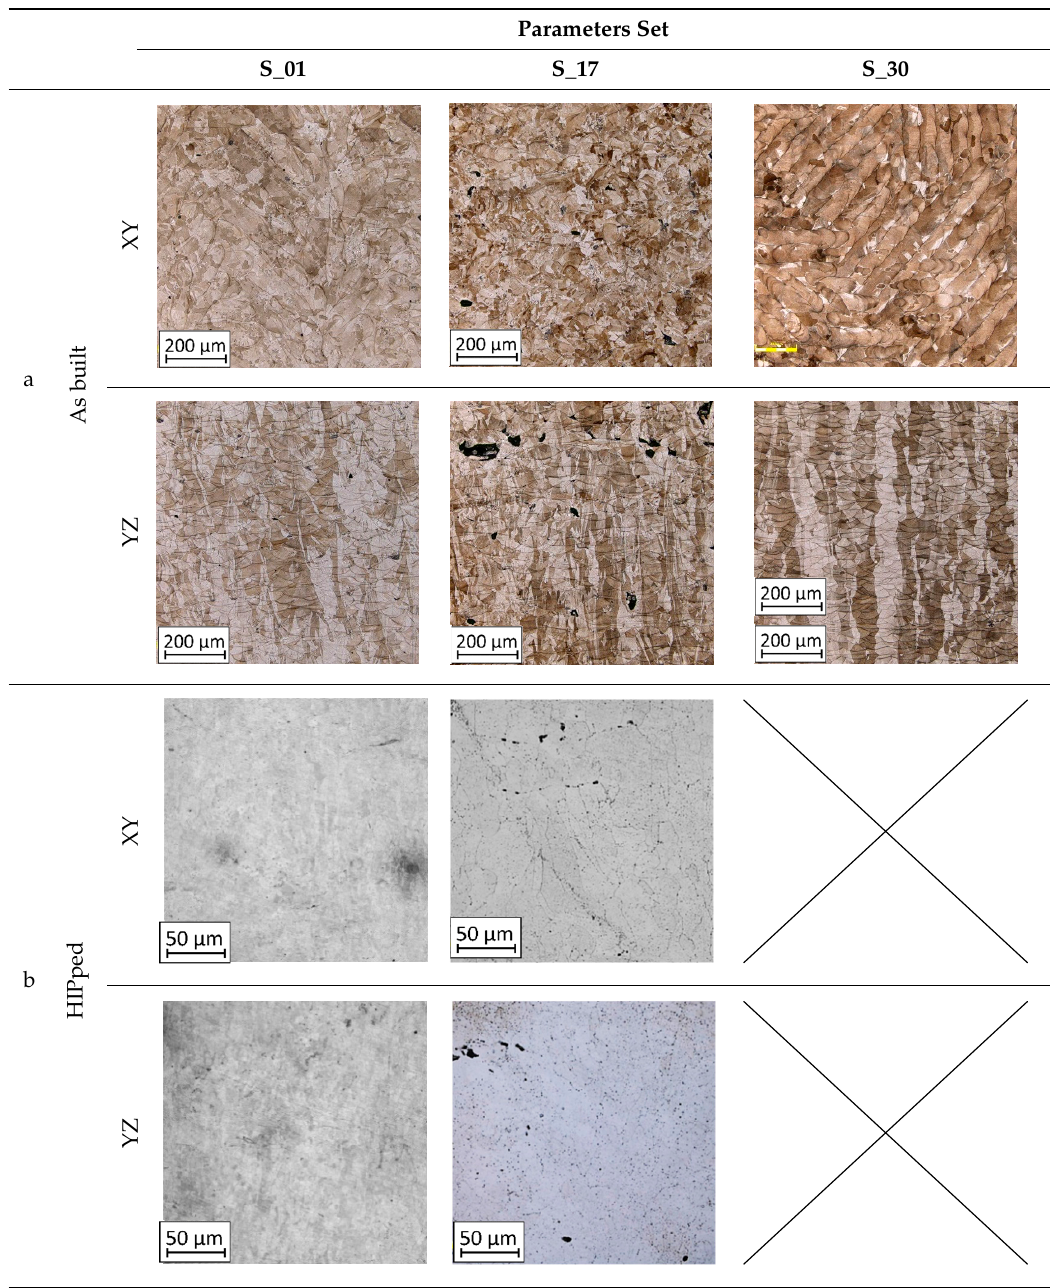
Table 4. Microstructure of S_01; S_17 and S_30 samples heat treated using different processes and their